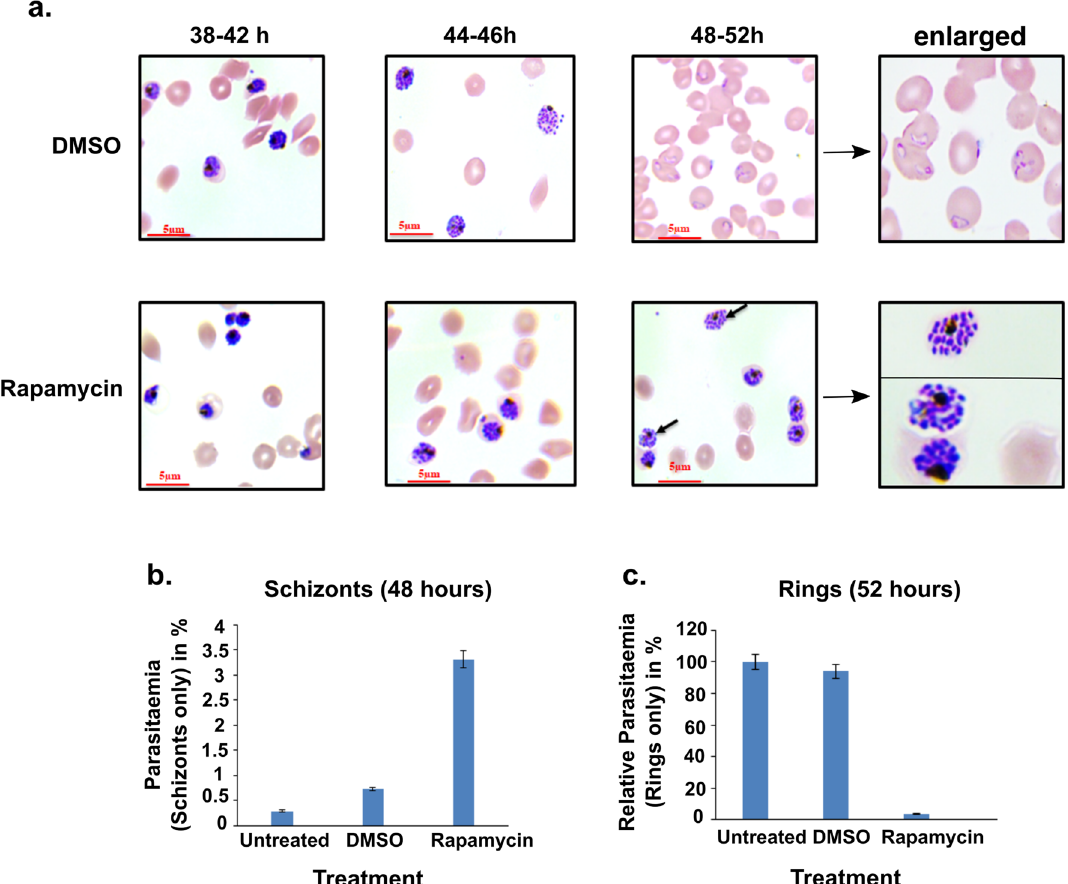
Figure 6. Induced deletion of pfmsa180 results in the arrest of parasite egress at the end of schizogony. ( a ) Images of Giemsa-stained thin blood smears 38–52 h after rapamycin or DMSO treatment. The mock-treated (DMSO) parasites egress and invade new RBCs to form ring stages, while the rapamycin-treated parasites remain as late stage schizonts, often without a visible PVM and the merozoites filling the whole erythrocyte (arrows). The last panel displays a zoom-in image for rings and schizonts. Scale bar = 5 µm. ( b ) Number of schizonts observed in untreated, mock-treated or rapamycin-treated i∆msa180 parasites 48 h after setup (~ 3% parasitemia). The percentage schizonts observed in each treatment was calculated from three independent experiments. Error bars depict standard error of mean. ( c ) The relative percentage of rings observed in untreated, mock-treated or rapamycin-treated iΔmsa180 parasites 52 h after setup. The percentage of rings in each treatment was calculated from three independent experiments with respect to untreated parasites, for which the parasitemia was set to 100%. Error bars depict standard error of the mean of two independent